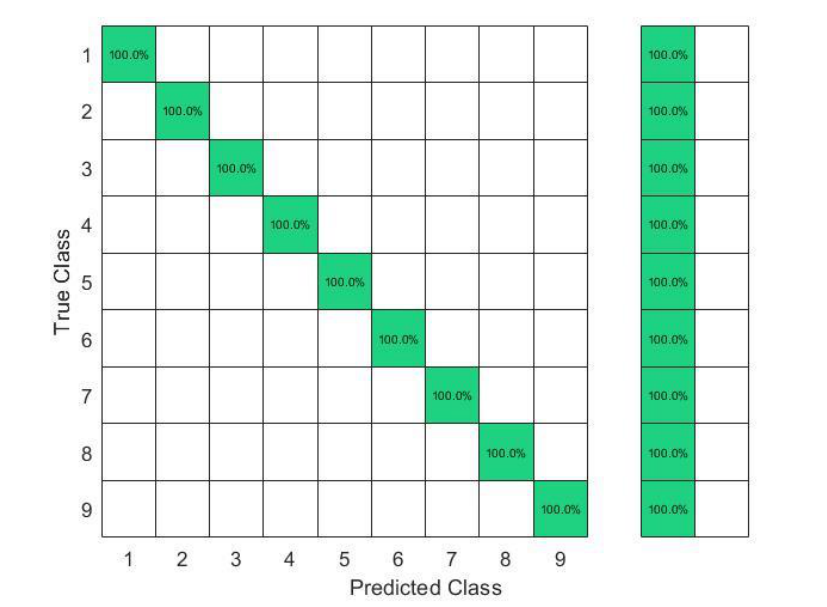
Figure 5. Confusion matrix of the KTGEL for one person for ASL numbers from 1 to 9:8